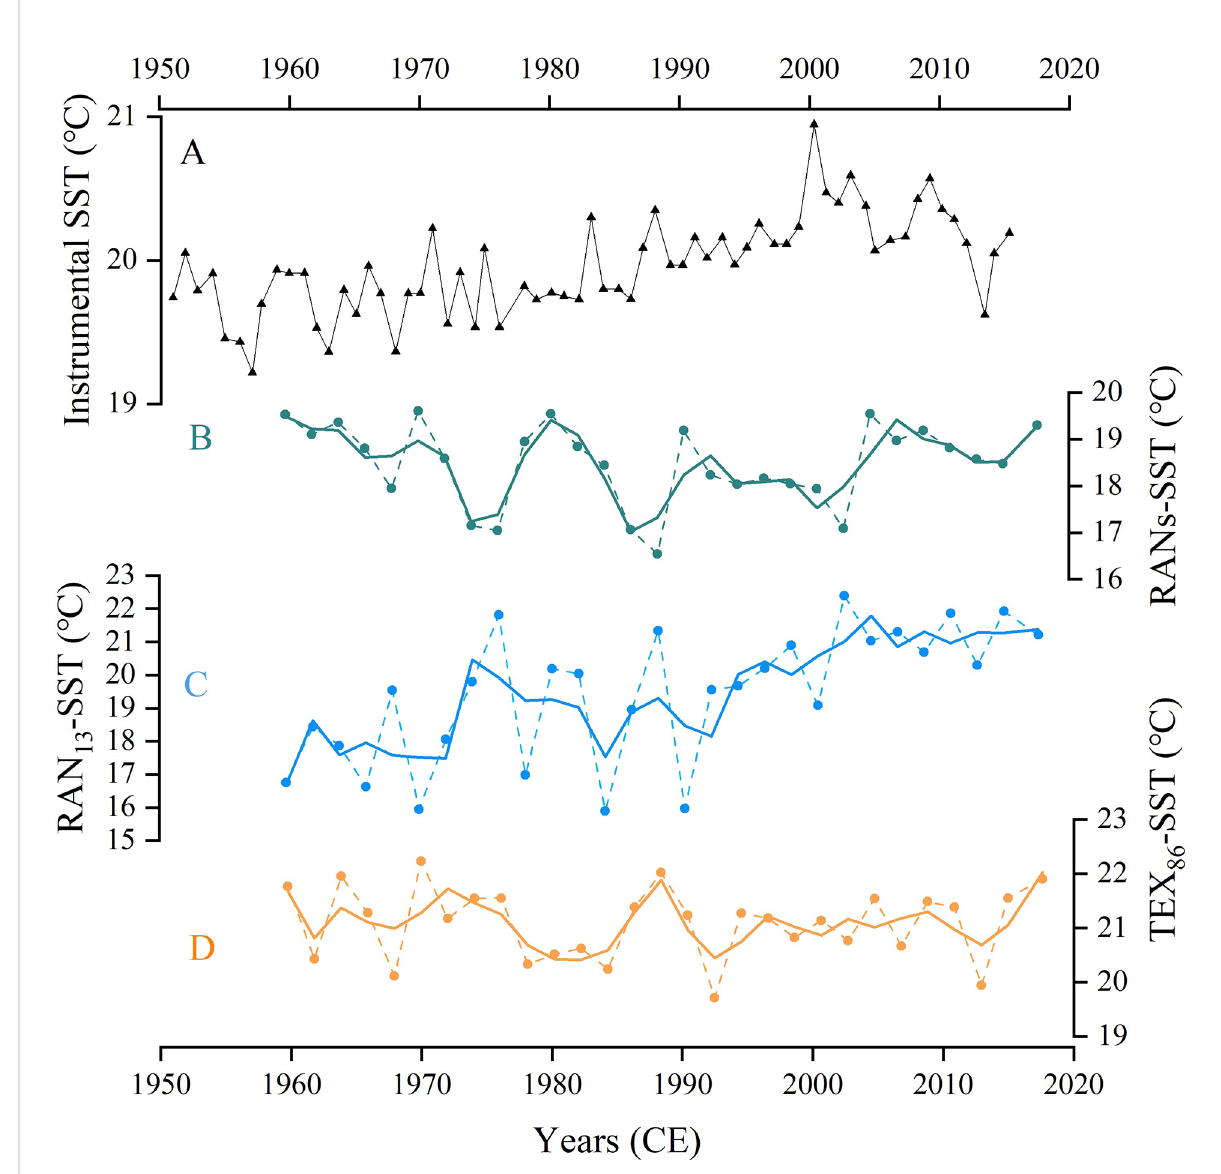
FIGURE 9 Comparison of RANs-SST record with other time-series and proxy records in in core B3. (A) Instrumental annual mean SST for core B3 (gridded from NOAA) since the 1950s. (B) and (C) showing RANs and RAN 13 derived SSTs, respectively (data from Yang et al. (2020a)). (D) Annual mean SSTs derived from TEX 86 (data from Lü et al. (2014)). The solid line represents 3 point moving average (B – D)